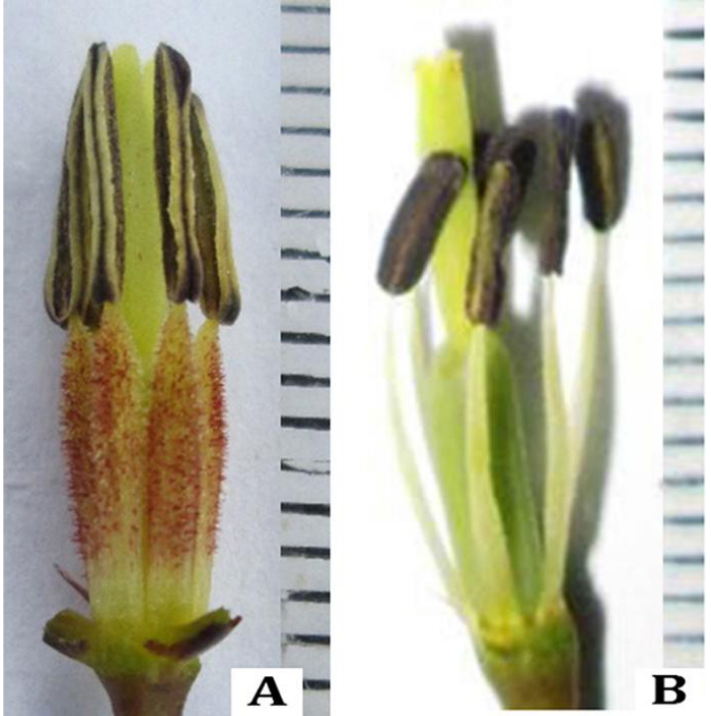
Fig. 3. Morphological differences in Fritillaria pinardii (A), and Fritillaria zagrica (B). These closely related taxa show clear morphological differences. Filament is smooth and thin (0.6 mm), and anther is short (3.7 mm) in F. zagrica, while, filament is 1.2 mm in width and the anther length is 6.2 mm in F. pinardii.